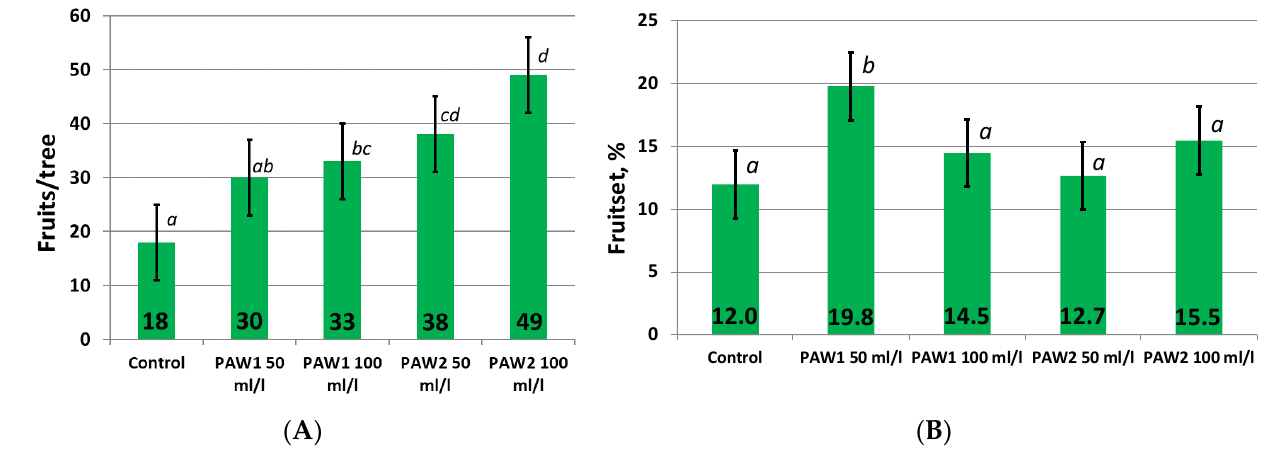
Figure 2. Fruit crop load before harvest ( A ) and fruitset from free pollination ( B ). Average values are presented. The values significantly differing, according to the Fisher’s LSD criterion (see Section 3), are marked with different letters.